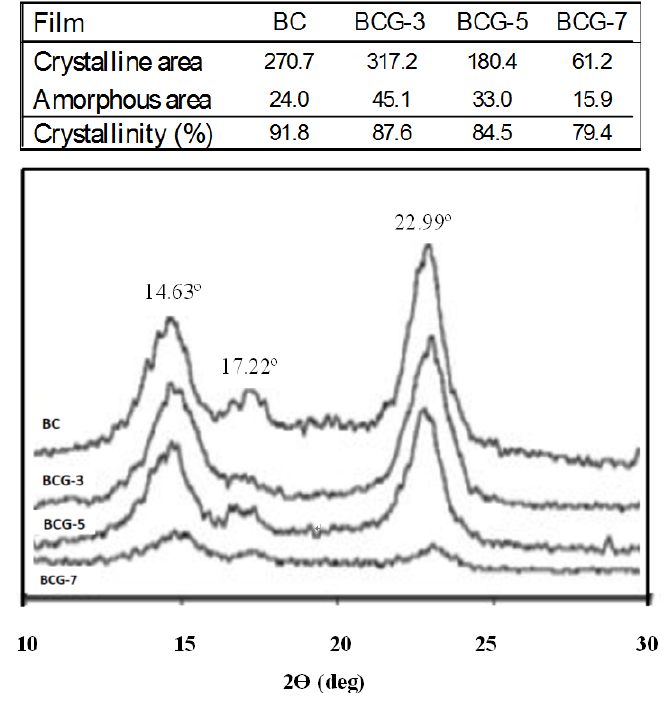
Figure 4. The X-ray diffractometer (XRD) patterns and crystallinity (%) of the BC